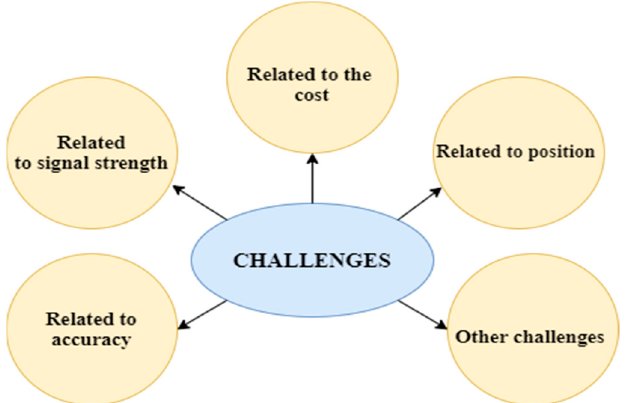
Figure 6. Overview of challenges .